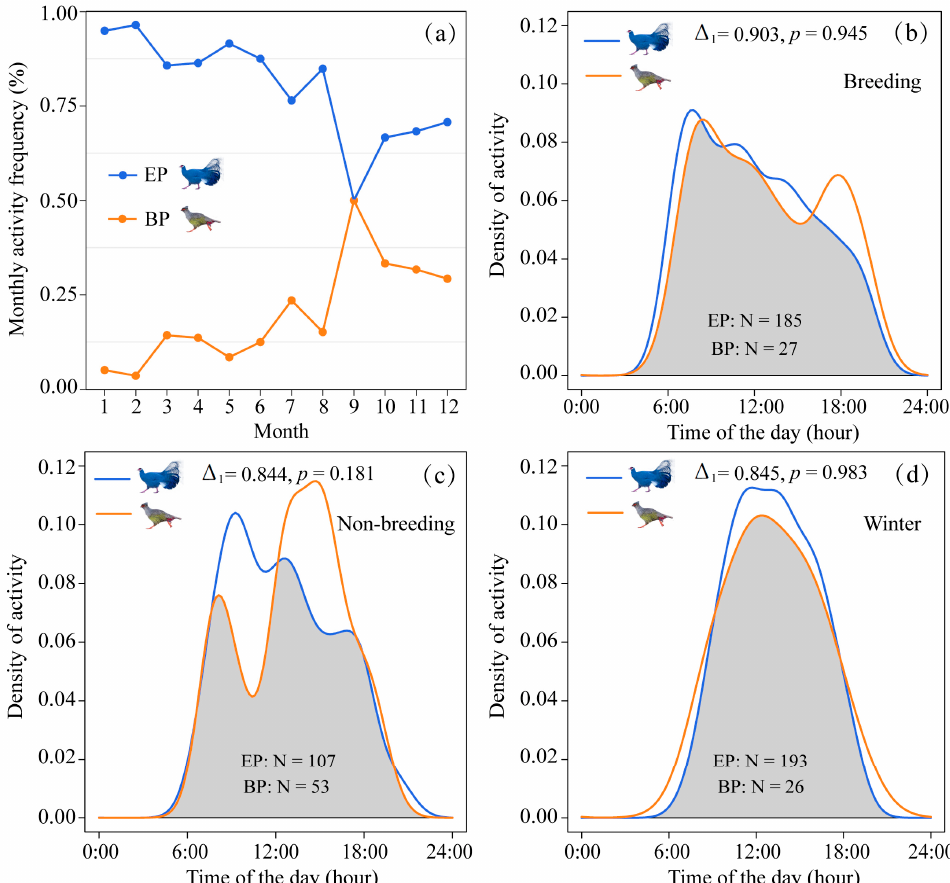
Figure 2. Temporal activity patterns of EP and BP in the QMNNR of Northwestern China. ( a ) Monthly activity patterns expressed as percent frequency. Diel activity and overlap of EP and BP in ( b ) breeding, ( c ) non-breeding, and ( d ) winter season. Gray shading shows the activity overlap of the two species, and the number at the top center of each graph represents the mean coefficient of overlap and the significant difference used in the Wald test.